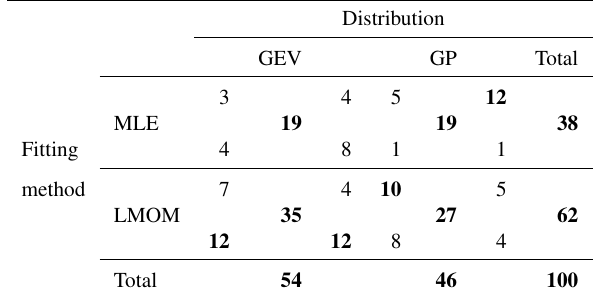
Table 6. Success rates of methods according to CRMSE 10 . The bold value in the center of each field indicates the overall count. The four numbers in the corners display the counts with respect to temperature minima (top left), temperature maxima (top right), temperature difference (bottom left) and precipitation totals (bot- tom right). Bold values indicate better